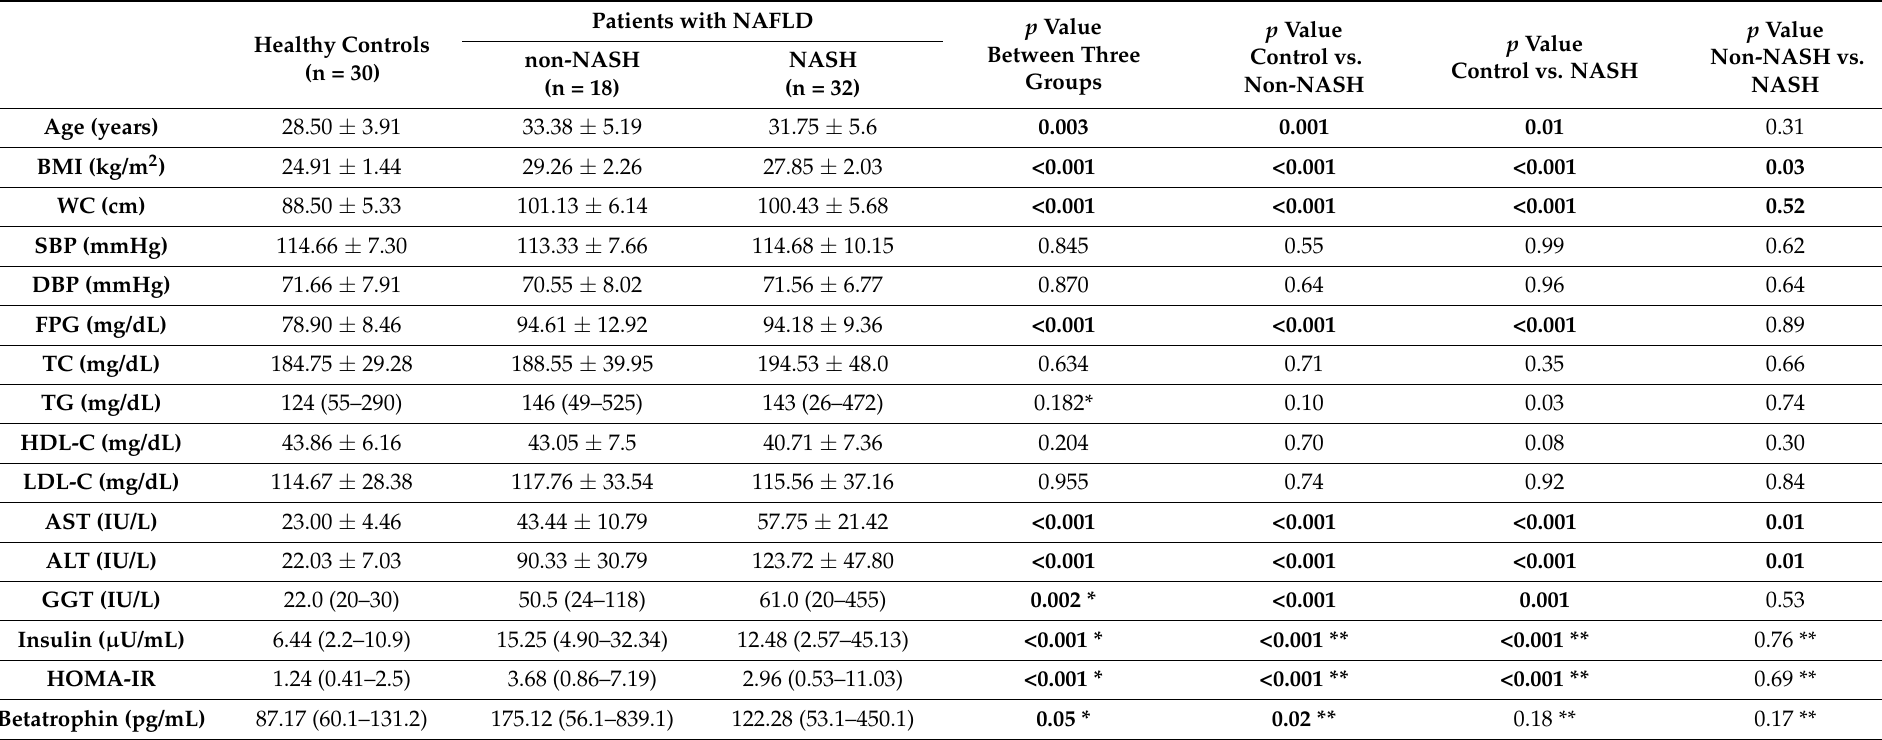
Table 1. The Comparison of the demographic and the laboratory parameters of the patients with NAFLD and the healthy controls. Patients with NAFLD Healthy Controls